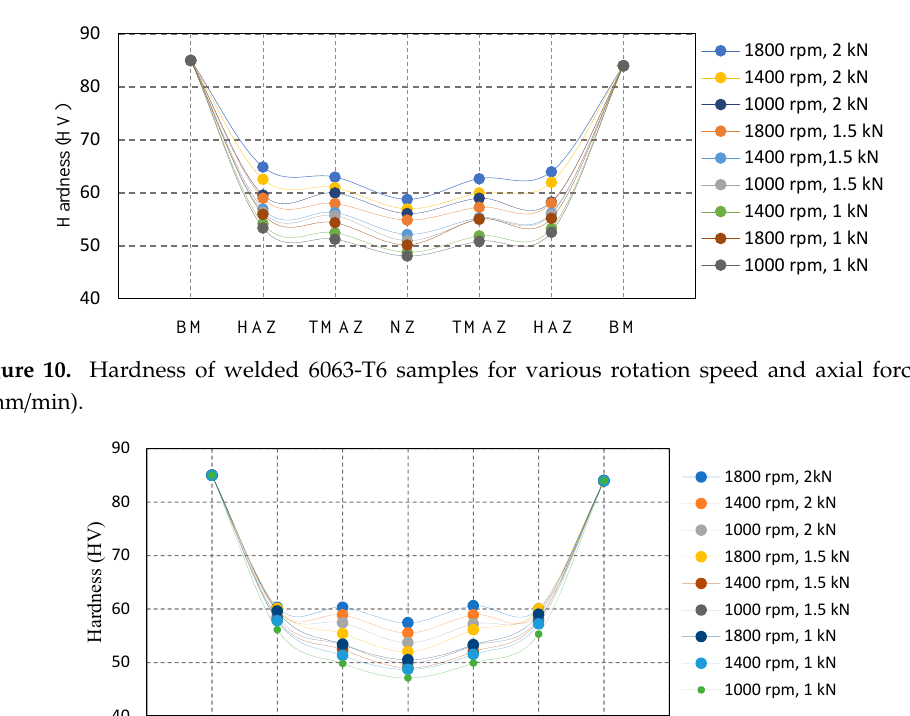
Figure 9. Zones in optical microscopic image of T-joint cross-section.